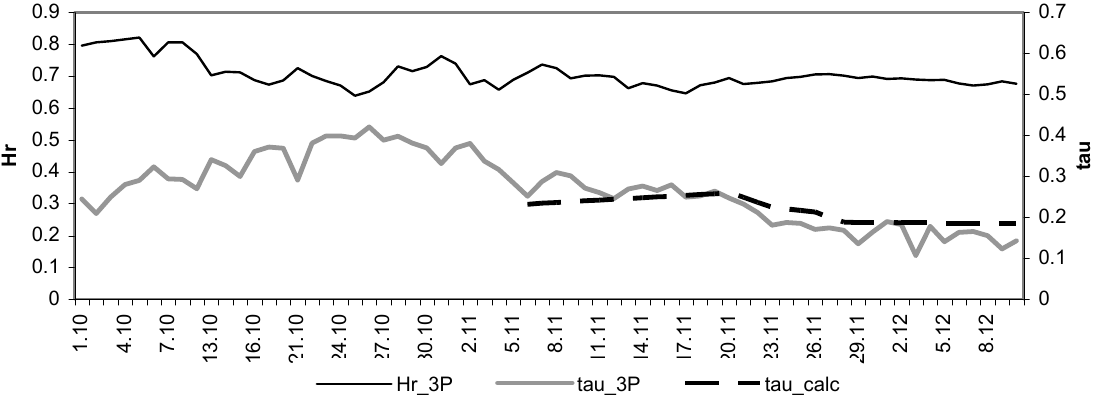
Figure 10. Development of vegetation optical depth at NADIR (tau_3P) and roughness (H _3P) as a result of a 3P-retrieval. Also shown is the calculated Tau parameter H r r